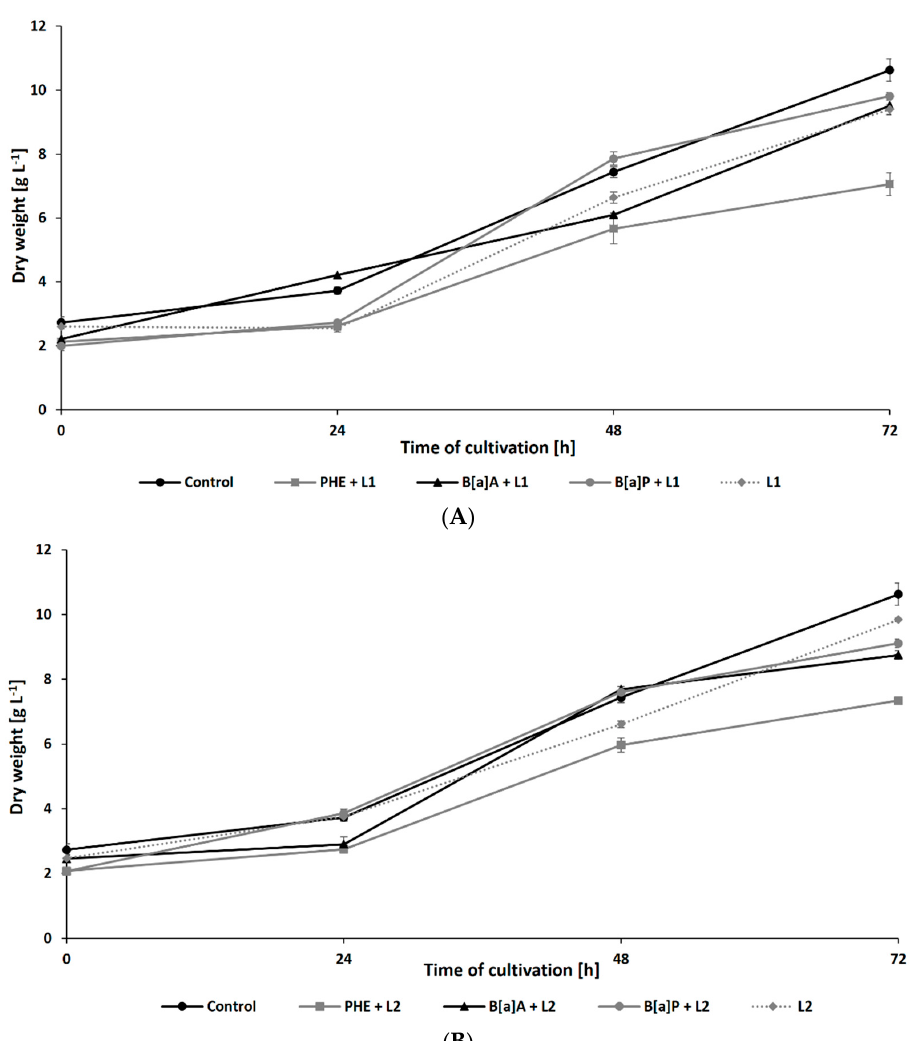
Figure 3. Dry weight of N. pironii during culture in Sabouraud medium containing PHE, B[a]A, or B[a]P (20 mg L − 1 ) with 20% of L1 ( A ) or L2 ( B ).